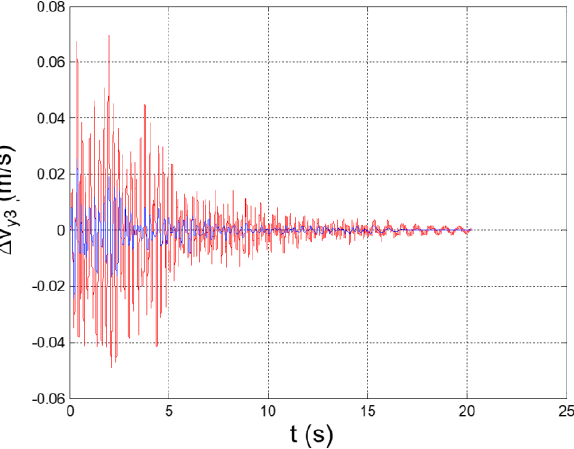
Figure 38. Seismic response, interstory speed at the 3rd floor ( Δ 𝑣 y3 = 𝑣 y3 − 𝑣 y2 ).